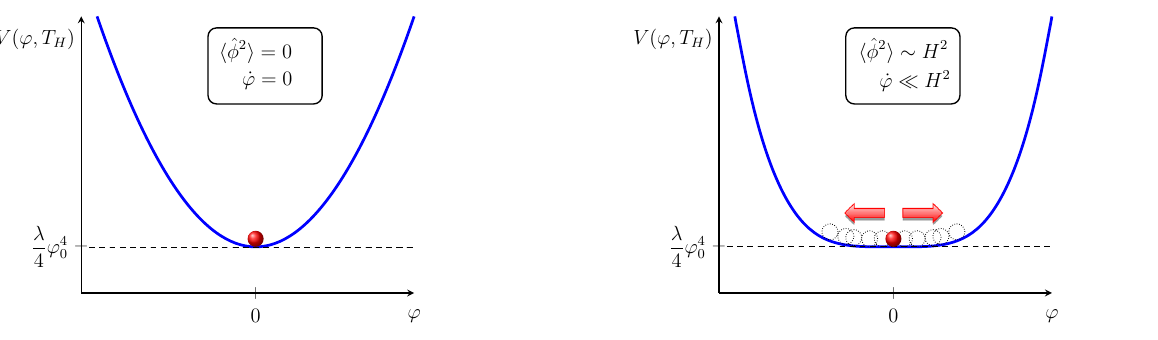
which is consistent with the requirement